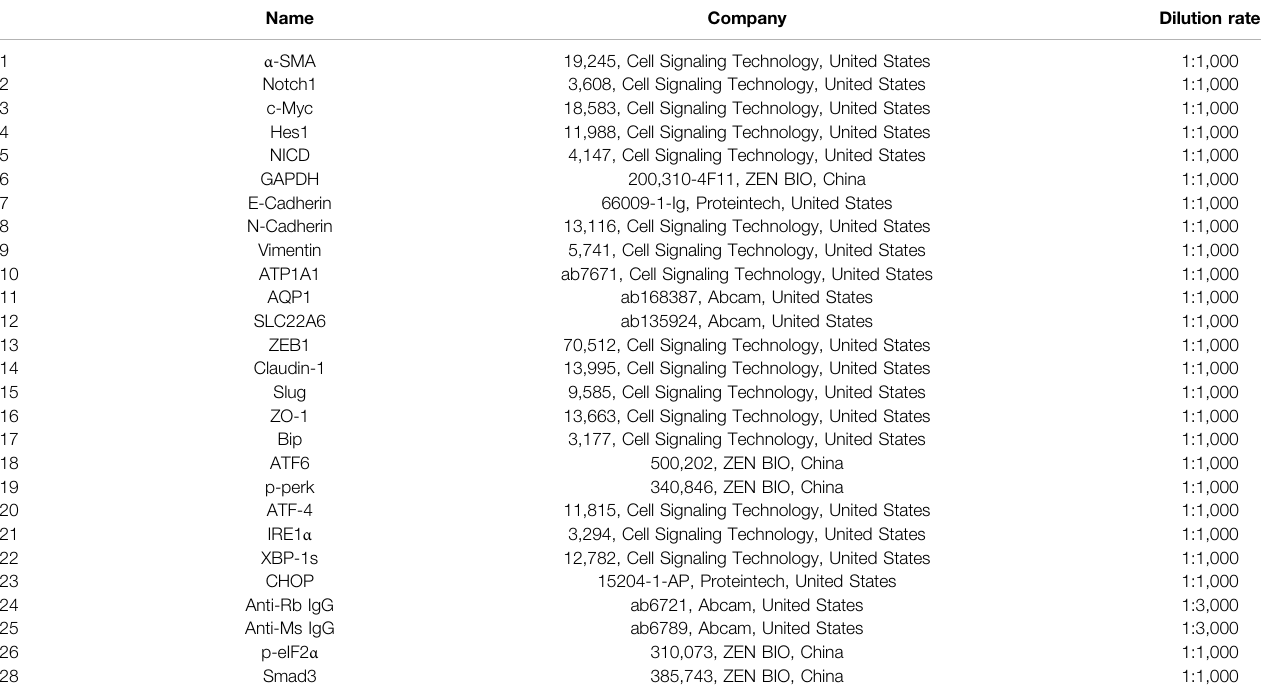
TABLE 1 | Information for all indicated antibodies used in western blots assay.